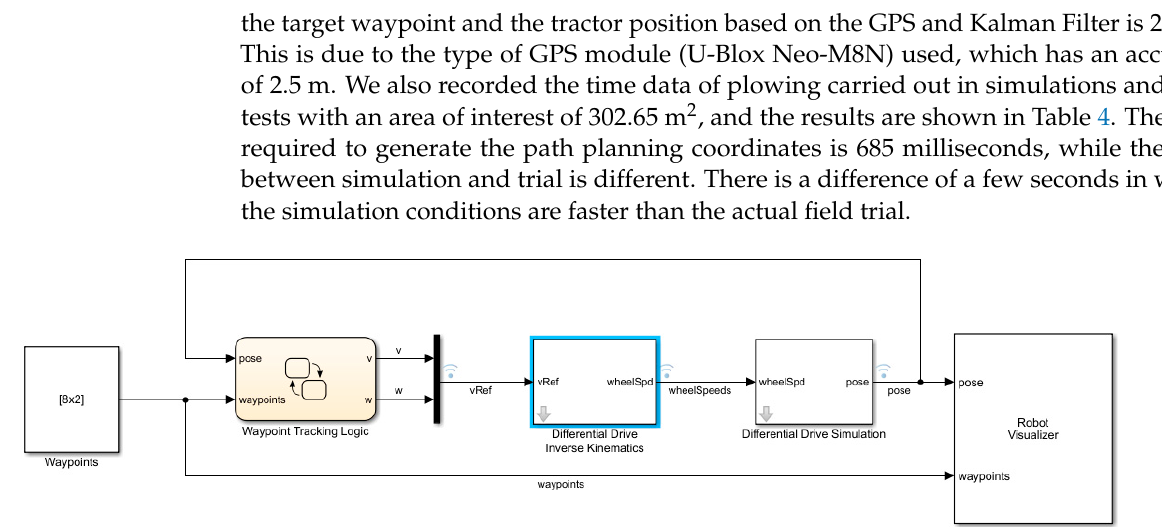
Table 3. Parameters for MatLab simulation.